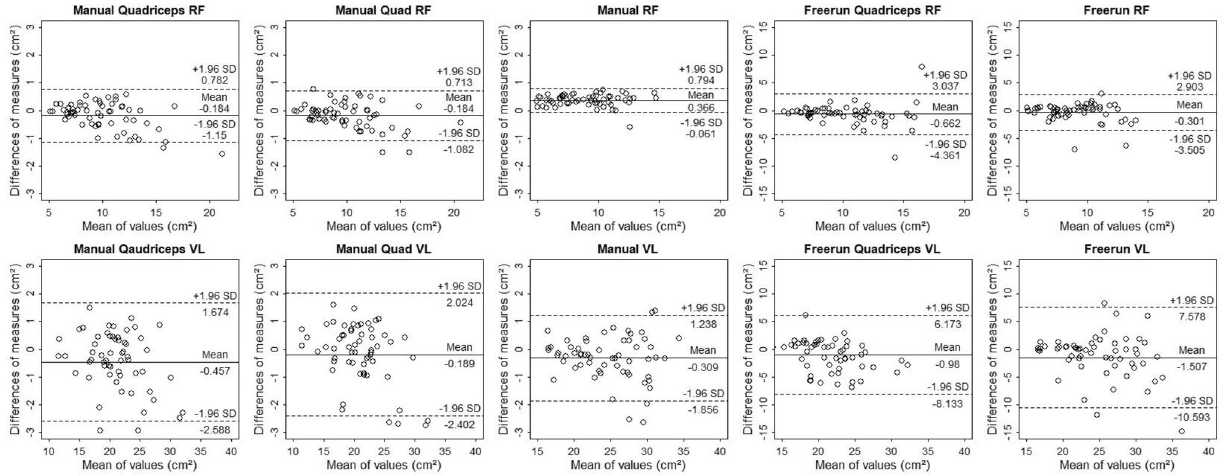
Figure 2. Bland–Altman plots of all modes using “Manual” outline-finder option compared to the manual measurement. M. rectus femoris (RF) and m. vastus lateralis (VL). The differences between measurements are plotted against measurement means. Dotted and solid lines illustrate 95% limits of agreement and bias. During the “Quadriceps” mode both muscles are analysed in one image. During the “Quad” mode, only one muscle is evaluated per image even though both muscles are displayed. During RF and VL modalities, both muscles were analysed in separate pictures. “Freerun” describes a trial where the suggested outlines were not manually corrected.